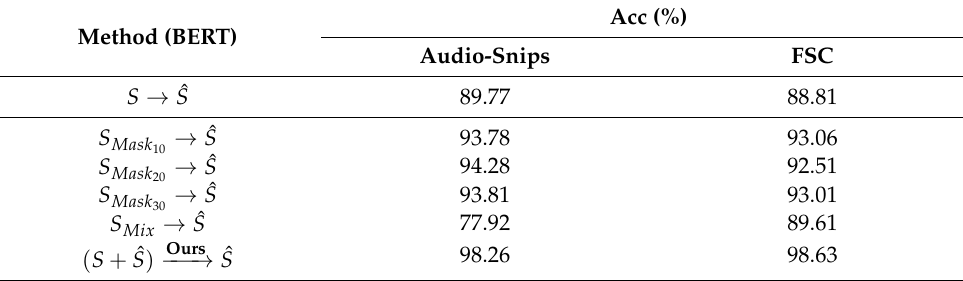
Table 8. The results of different augmentation approaches used in the downstream